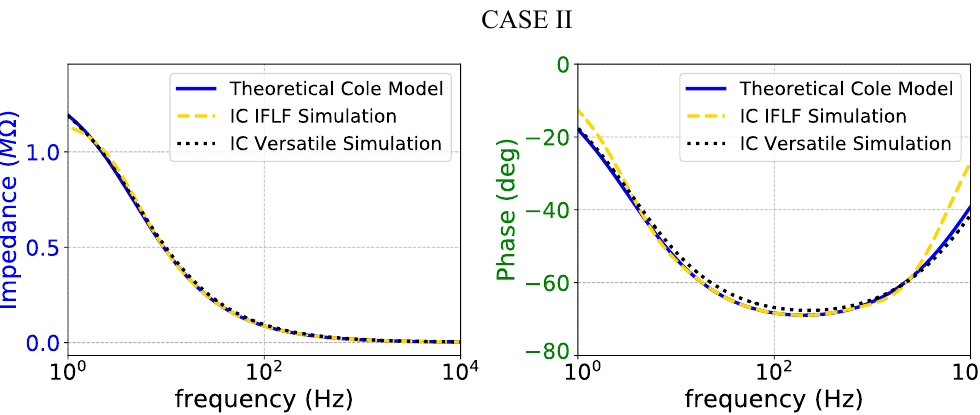
Figure 24. Impedance magnitude ( left ) and phase response ( right ) of the case II fractional-order skin